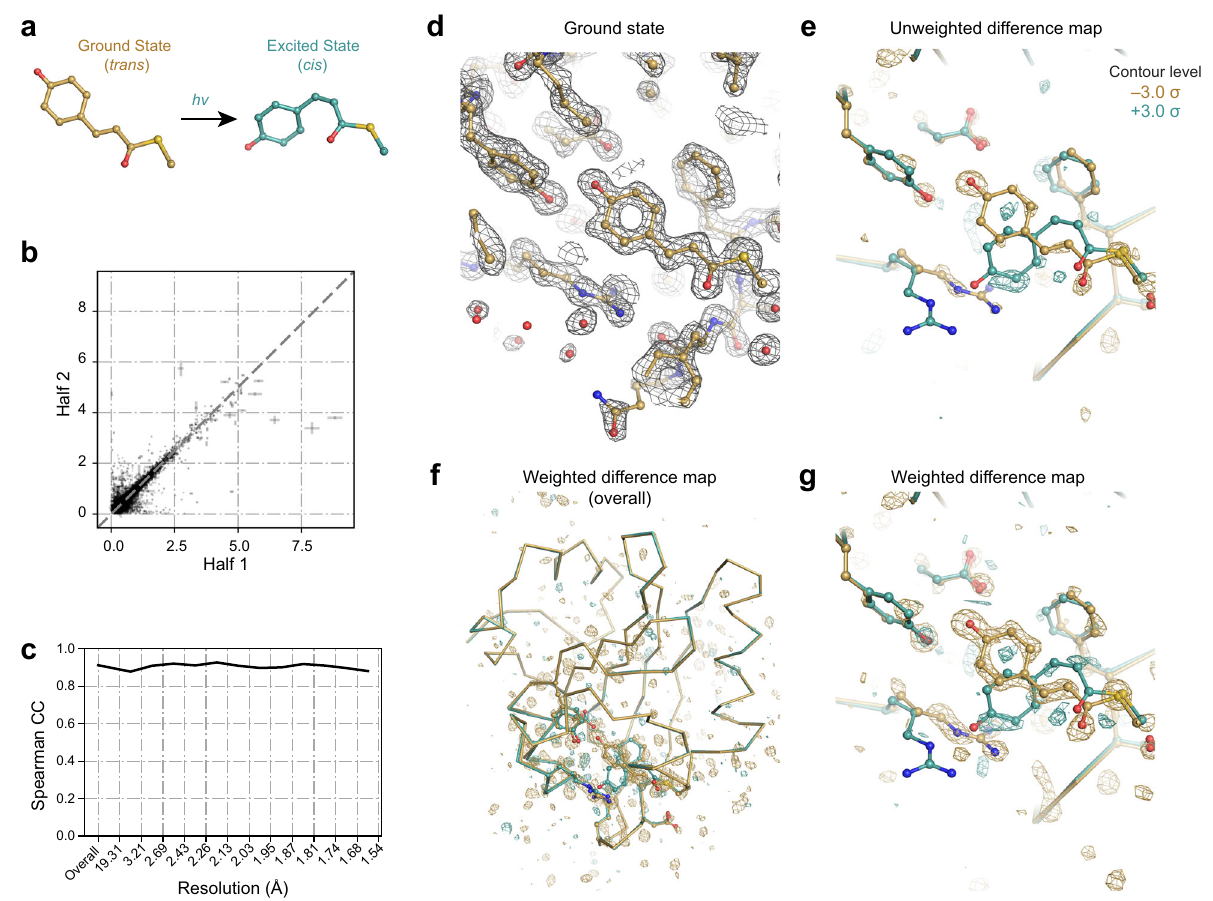
Fig. 4 | Careless accurately merges time-resolved polychromatic diffraction data. a When exposed to blue light, the PYP chromophore undergoes trans -to- cis isomerization. In total, 40 images from a single crystal of PYP were processed: 20 wererecordedinthedarkstate,and20wererecorded2msafterilluminationwitha blue laser pulse. Eachimage isthe result of 6 accumulated X-ray pulses. The signal to noise and multiplicity of each time point is reported in Supplemental Fig. 4. b Thedatawererandomlydivided inhalfbyimageand mergedwithscalefunction parameters learned by merging the full data set. Merging with Careless gave excellent correlation between the structure factor estimates of both halves. Error bars indicate the standard deviation of the structure factor posteriors for the half data sets around the posterior means. c Half-dataset correlation coef fi cients as a